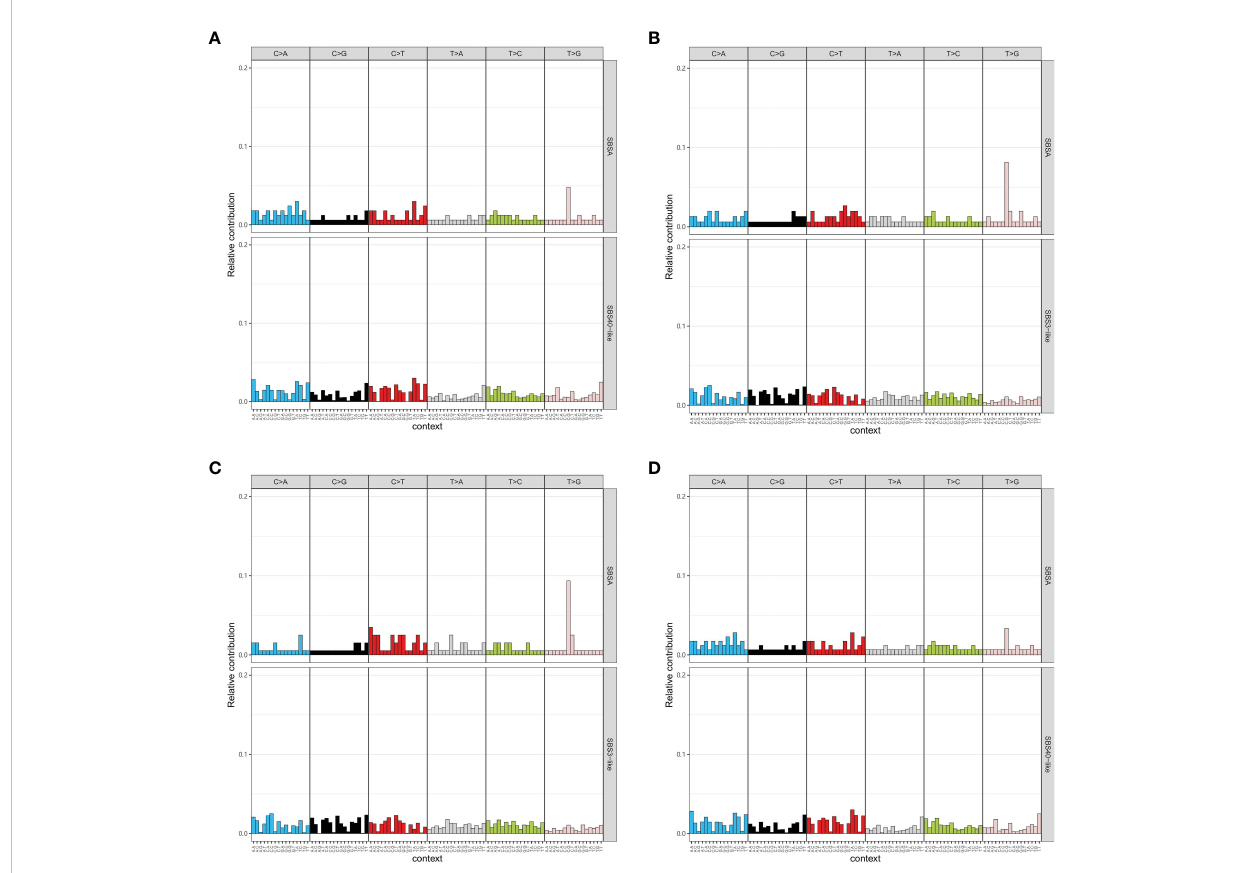
FIGURE 4 Mutational signature of tumors with different grades. The mutational signatures of high-grade tumors (A) , middle-grade tumors (B) , and low-grade tumors (C) are compared to COSMIC signatures. (D) Tumors with mutations in the Epstein – Barr virus-related pathway have a signature similar to COSMIC